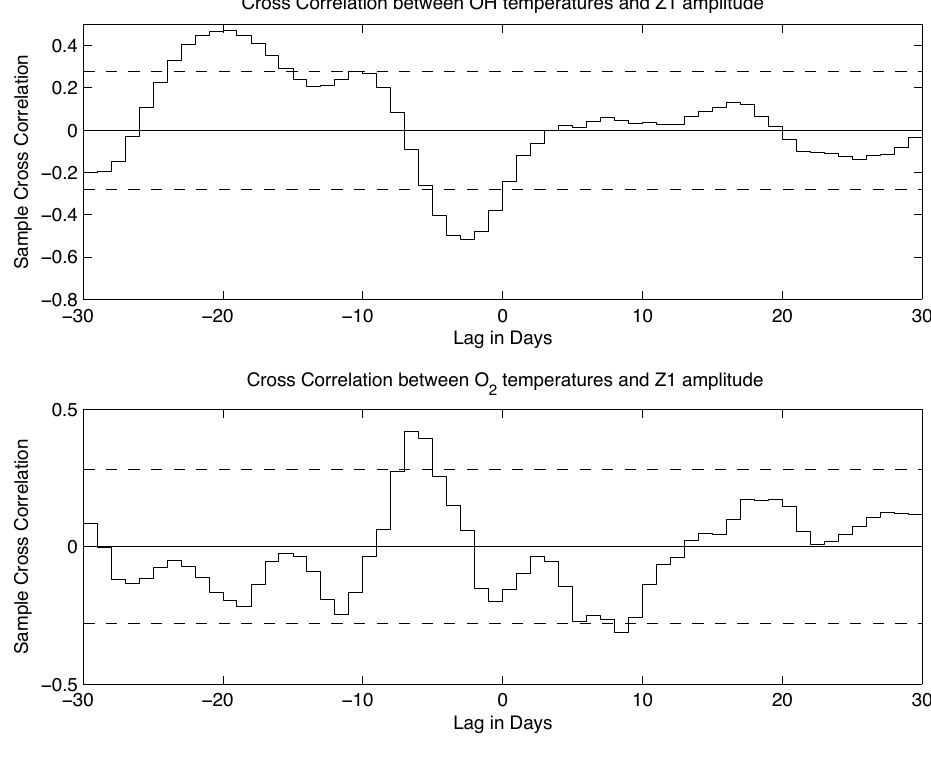
Fig. 9. Top: Cross-correlation between OH rotational temperatures (shown in Fig. 5) and daily temperature amplitudes of Z1 (shown in Fig. 8). Negative lag here represents OH temperatures lagging Z1 amplitudes. Dashed lines are the upper and lower 95% confidence bounds. Bottom: Same as the top panel but for O 2 rotational temperatures.